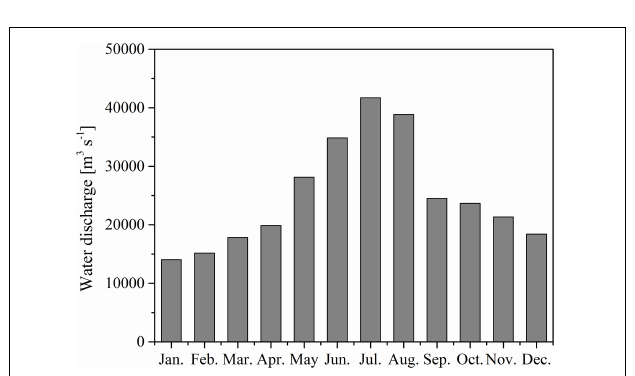
FIGURE 11 | Monthly water discharge from Changjiang River in 2018 (Datong station, data derived from the China Bureau of Hydrology, http://www.mwr.gov.cn/).